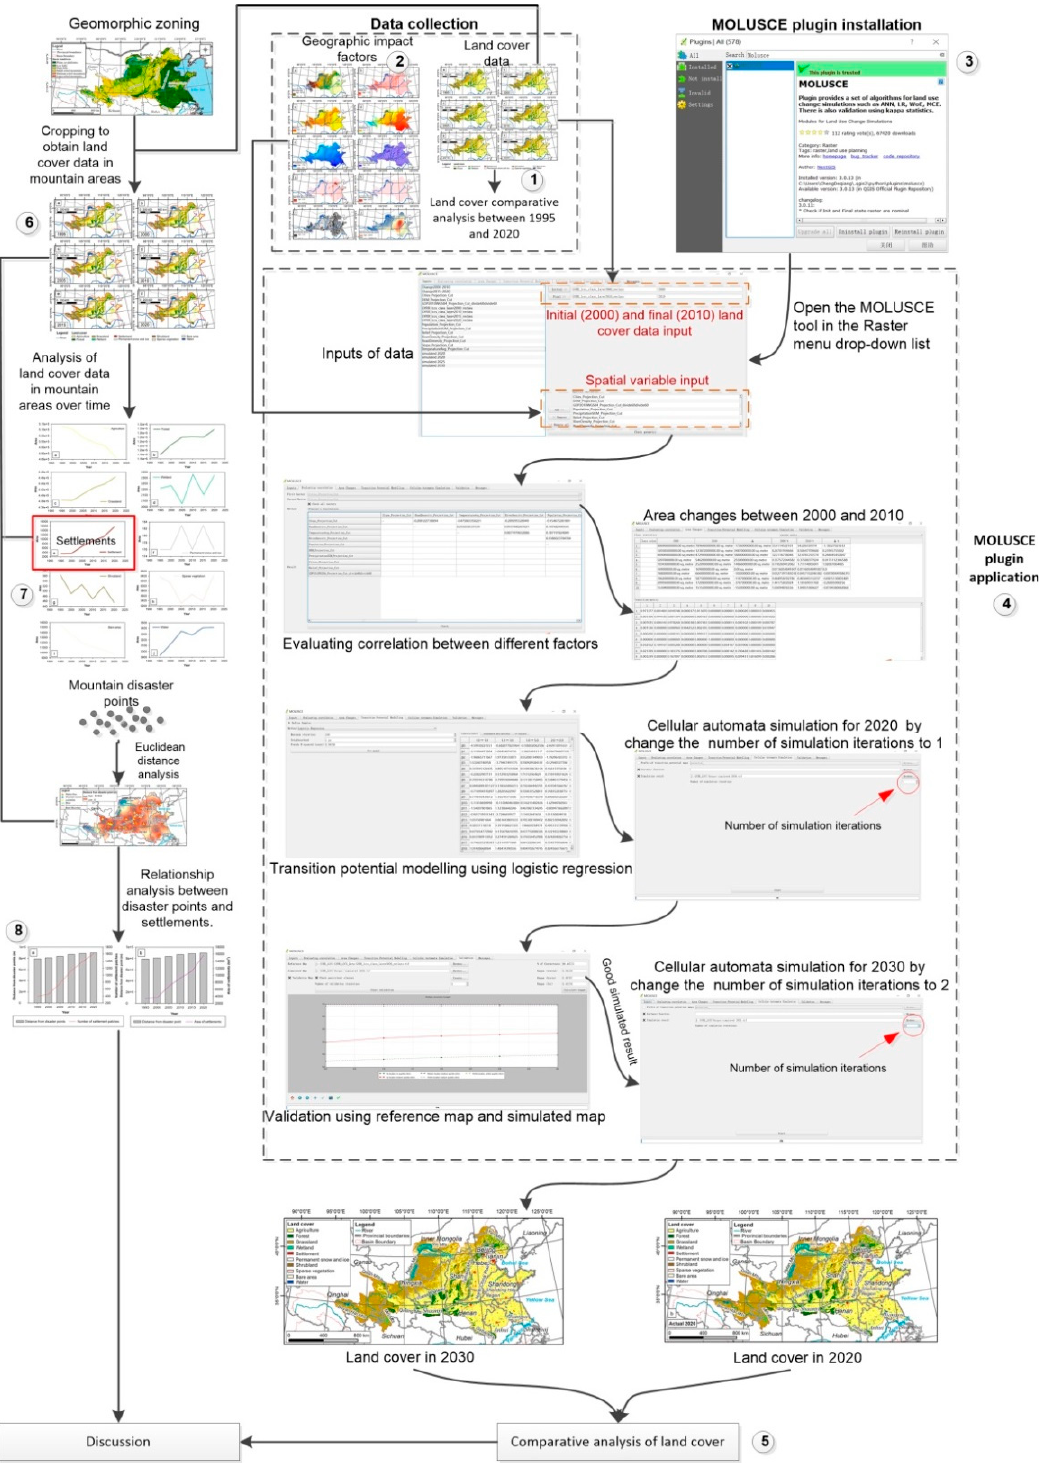
Figure 5. Technology roadmap. In this technical route, we not only paid attention to the land cover change in the whole GYRR, but also paid attention to the land cover change in mountainous areas which account for two-thirds of the whole GYRR, especially the change in residential areas in the mountainous